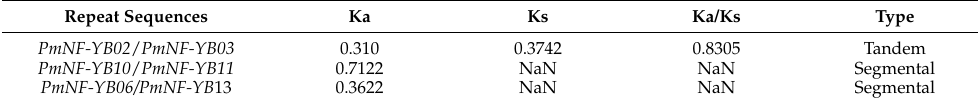
Table 2. The Ka/Ks values of repeated PmNF-Y gene